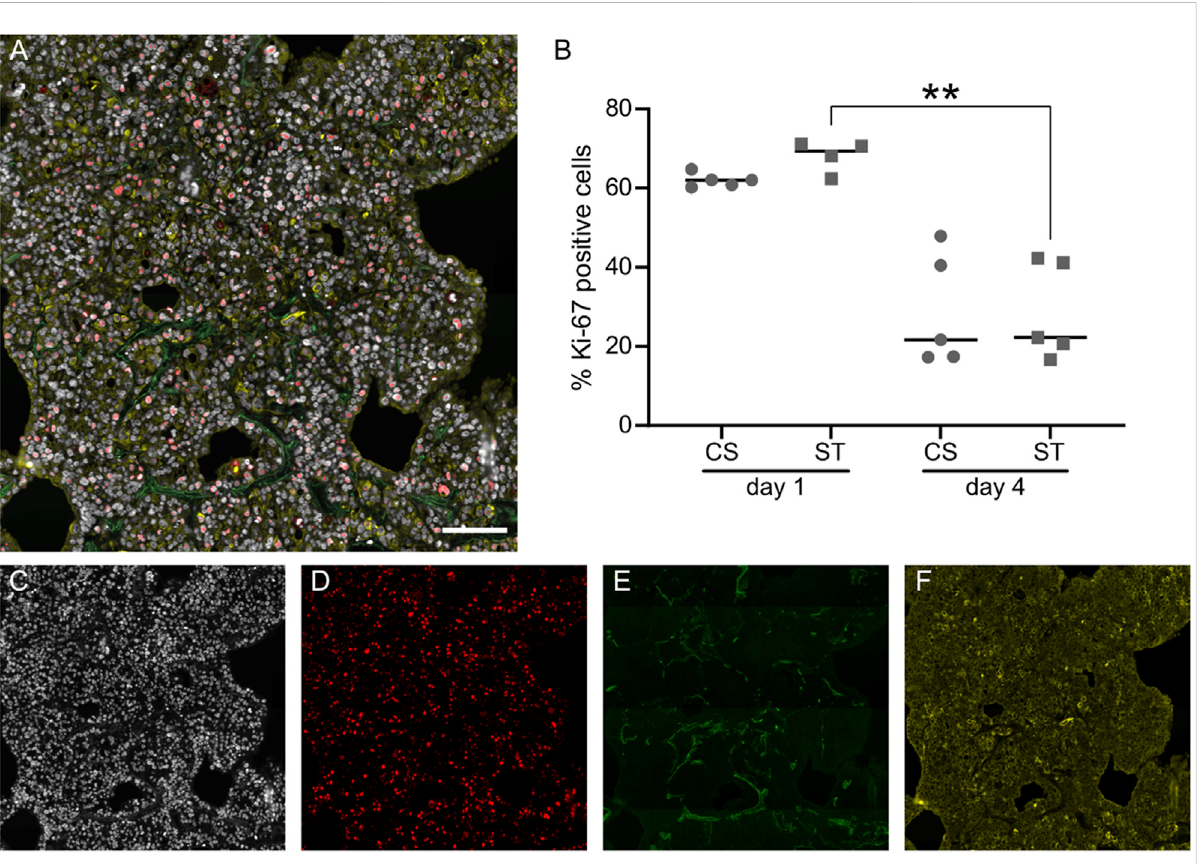
FIGURE 3 Evaluation of cell proliferation with Ki-67 staining and quanti fi cation. Representative image of lung slices stained against Ki-67 (red), epithelial marker pan-cytokeratin (yellow) and nuclei (DAPI, white), while auto fl uorescence at 495/519 nm (FITC) was used to visualize ECM fi bers in the lung slice (A) . Quanti fi cation of Ki-67 in cell nuclei expressed as proportion of positive cell nuclei (B) , data points represent data from individual lung slice samples, horizontal lines show group median. Individual channels from (A) are shown in (C – F) . Scale bar is 100 μ m, CS: cyclic stretch (circles), ST: static culture (squares), **: p -value <